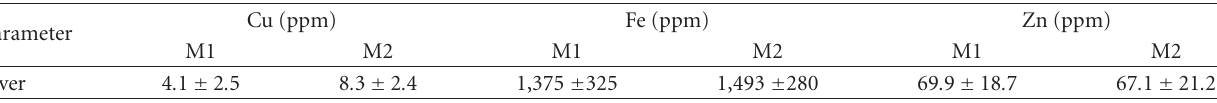
Table 2: Mean ± standard deviation of hepatic Cu, Fe, and Zn concentration on dry matter basis in sheep at the two visits on the farm. Cu (ppm) Fe (ppm) Zn (ppm) Parameter M1